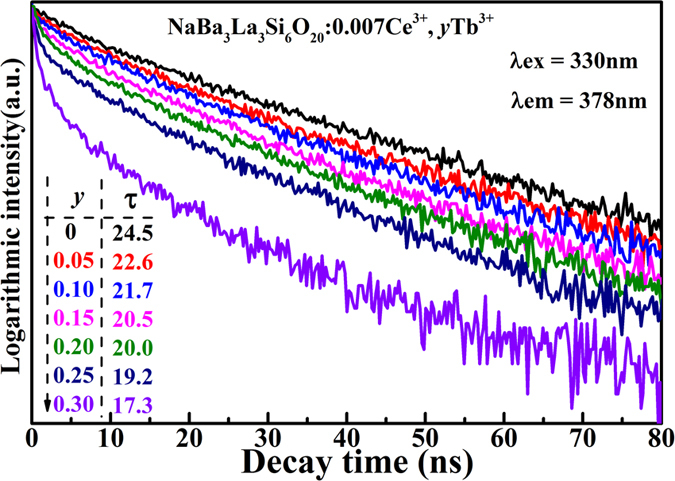
The decay curves for the emission of the Ce3+ ions in the NaBa3La3Si6O20:0.007Ce3+, yTb3+ phosphors excited under 330 nm and monitored at 378 nm.